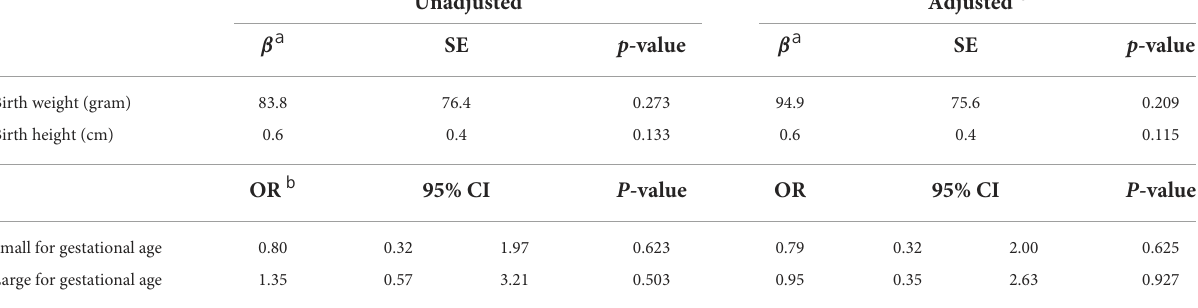
TABLE 3 Linear and logistic regression of birth outcome in children. Unadjusted Adjusted c β a SE p -value